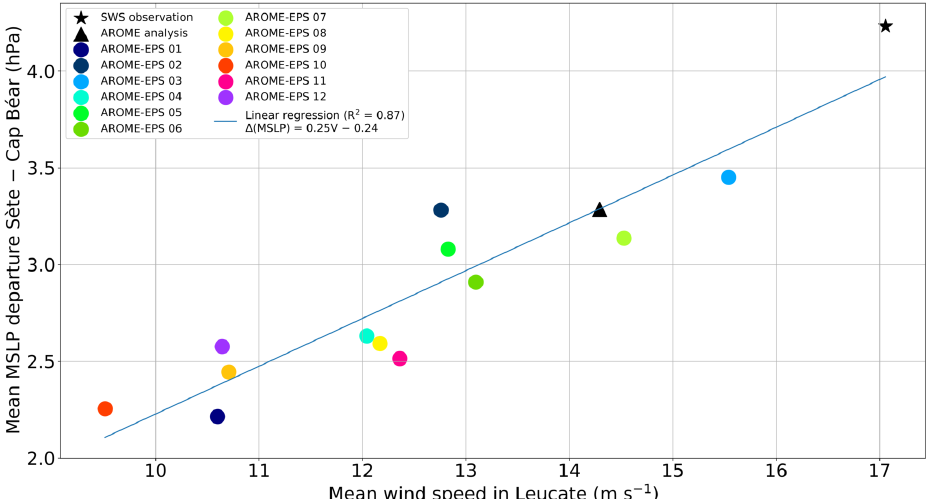
Figure 13. SWS observation, AROME-France analysis, and AROME-EPS forecasts of 10m wind speed blowing from the Mediterranean Sea (sector 90–150 ◦ ) as a function of the MSLP departure between Sète and Cap Béar, averaged over the event between 19:00UTC on 14 October and 07:00UTC on 15 October (period taken 1h ahead of the period of interest). To give an order of magnitude, if we hypothetically consider that the geostrophic balance applies near the ground, the ageostrophic wind is equal to zero, and the pressure field is such that the Sète–Cap Béar orientation is always parallel to the pressure gradient during the event, the slope of the regression line would theoretically be about 0.13 (with a y intercept equal to zero).